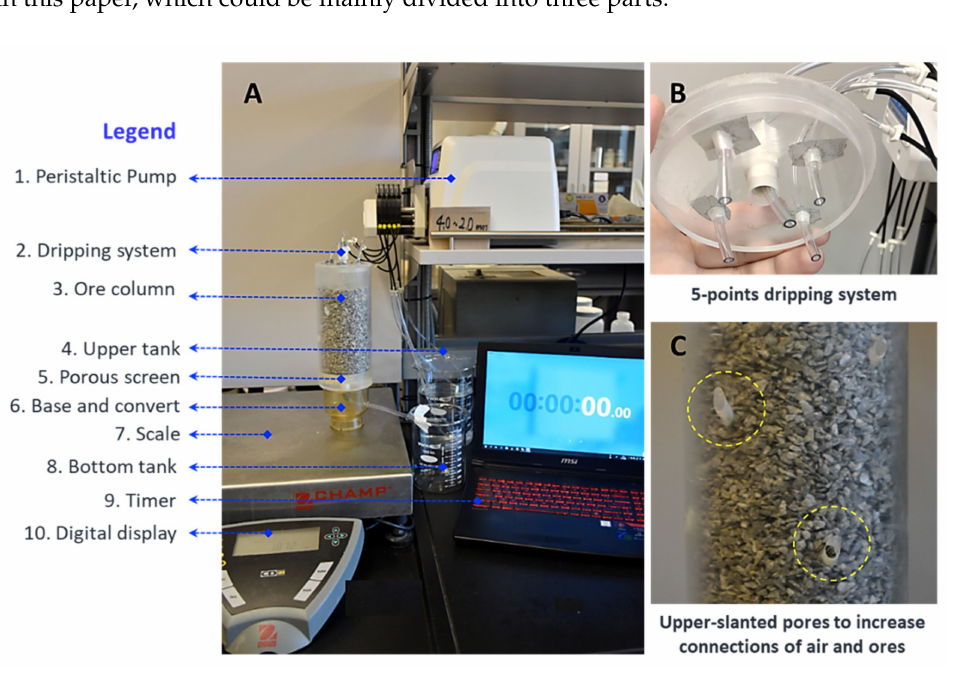
Figure 1. Experimental setup of stepwise liquid irrigation tests. ( A ): liquid holdup rate real-time characterization test bench; ( B ): 5 points dripping; ( C ): upper-slanted pores to eliminate pressure dif-